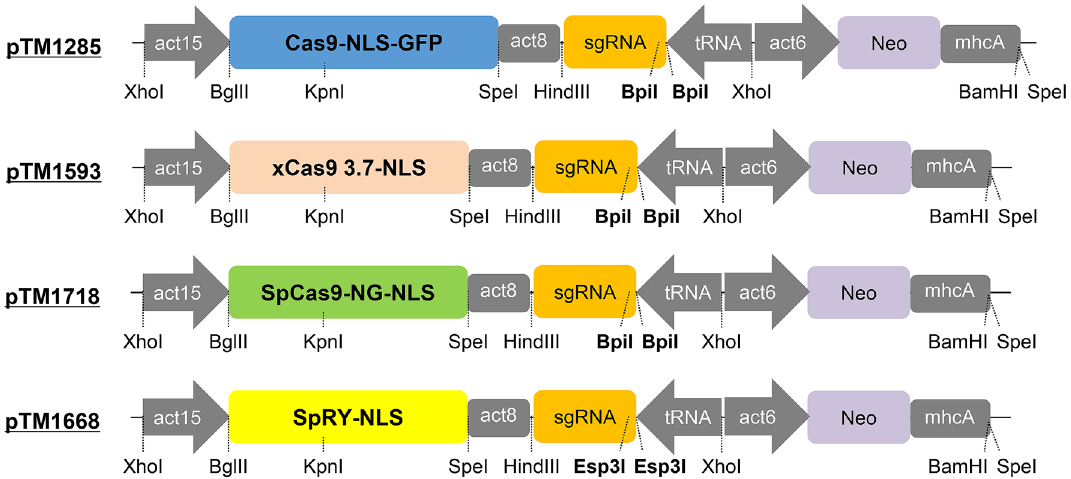
Figure 1. Diagrams of all-in-one Cas9 and sgRNA expression vectors used for gene manipulation in D. discoideum . act15, act15 promoter; act8, act8 terminator; tRNA, isoleucine tRNA; act6, act6 promoter; neo, neomycin resistance